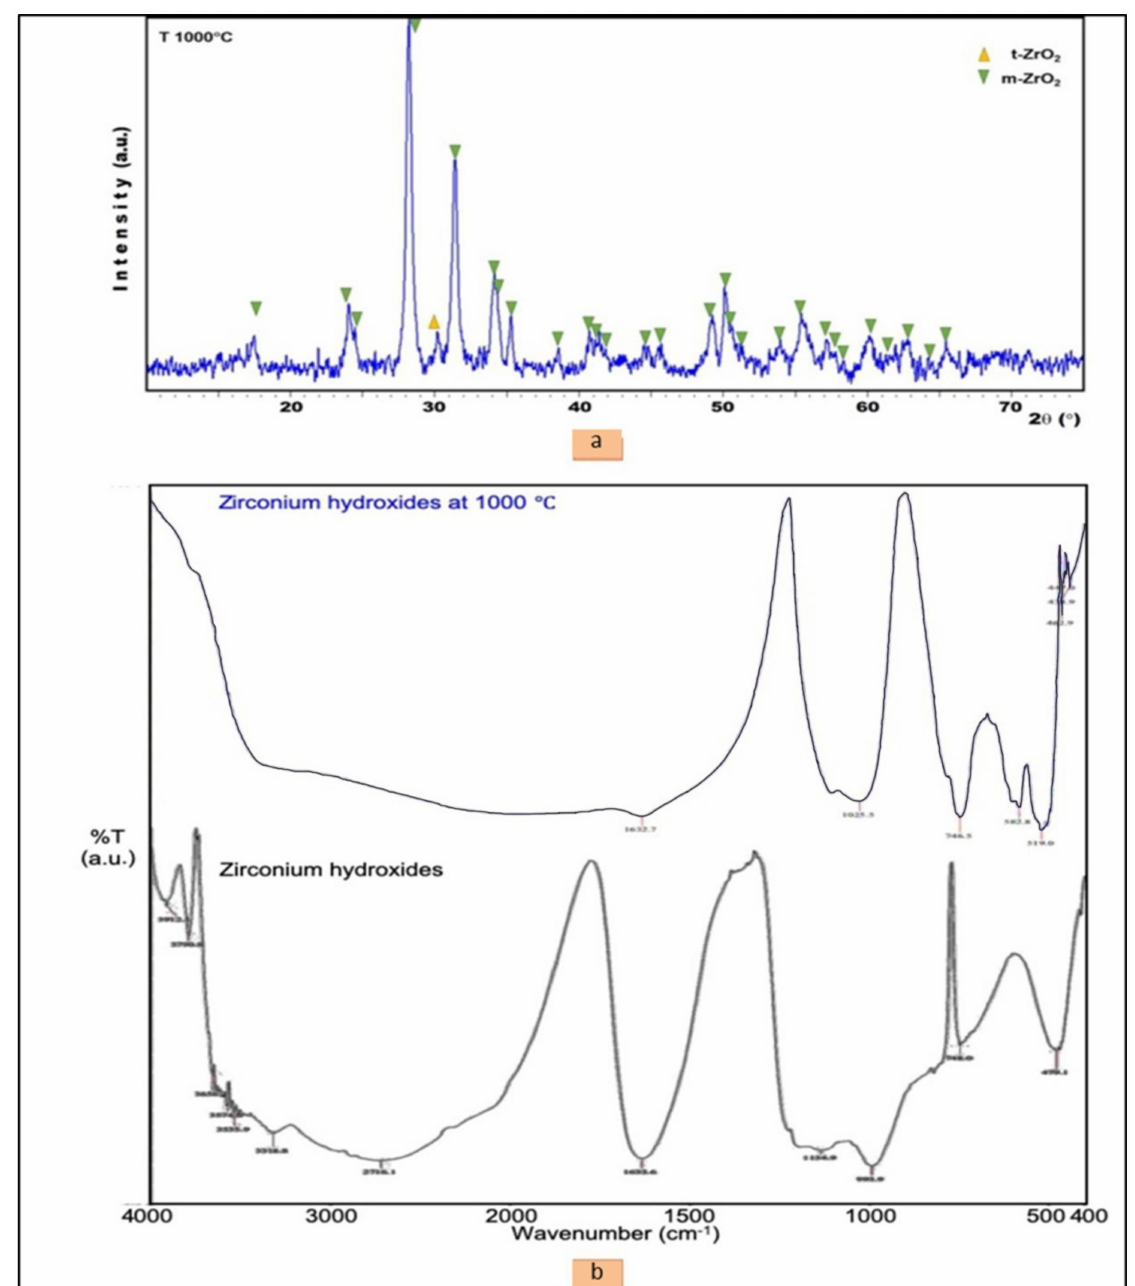
Figure 1. XRD pattern of the calcined zirconium hydroxide ( a ); and the FT-IR spectra of zirconium hydroxides before and after calcination at 1000 ◦ C ( b